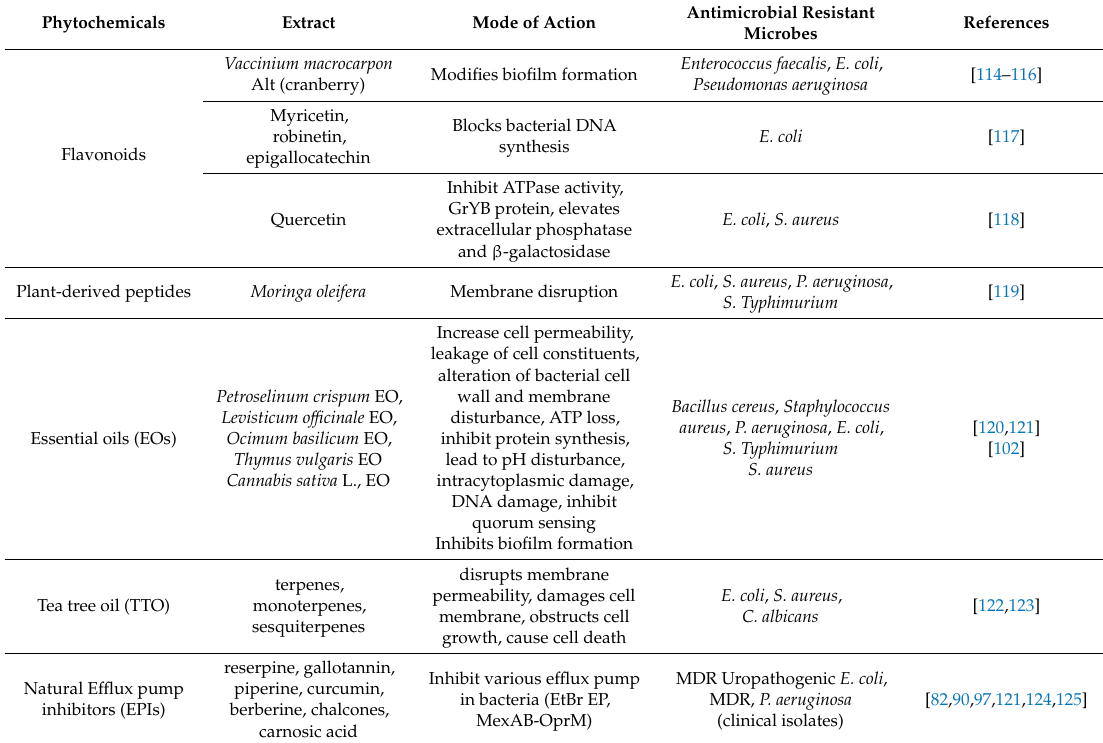
Table 2. Mechanism of action of plant-derived substances (PDSs) against broad range of